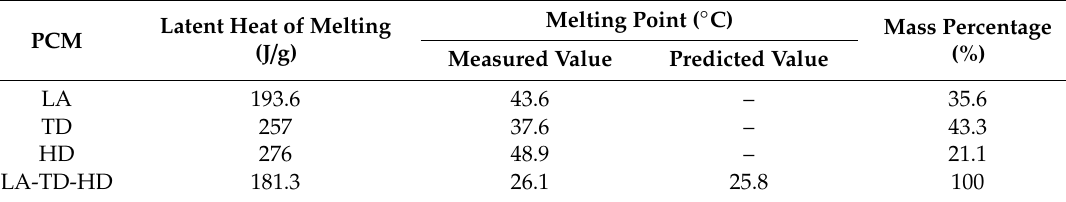
Table 1. Specific parameters and mass percentages for LA, TD, and HD of phase change